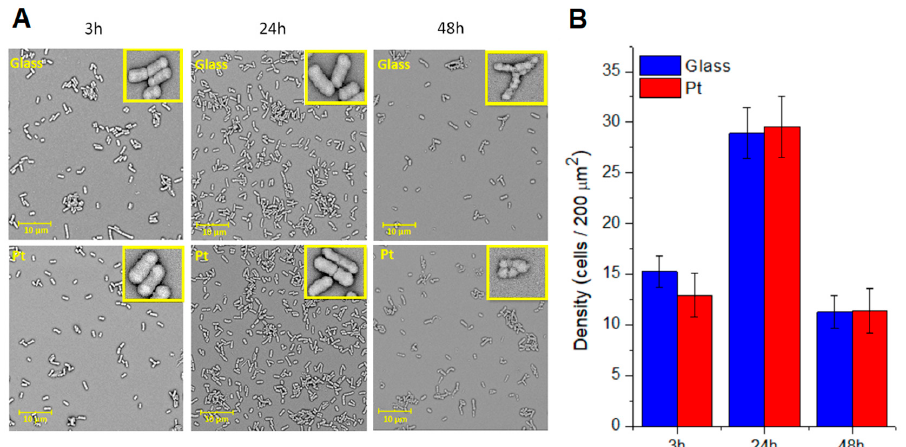
Figure 3. Colonization of Escherichia coli on the surfaces of bare and Pt-coated glass slides. ( A ) SEM micrographs presenting bacterial populations grown for 3 h, 24 h and 48 h on the surface of samples; ( B ) bacterial cells density (number of bacterial cells per 200 µm 2 ) calculated from SEM images.